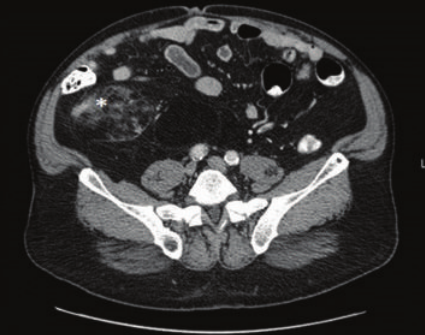
Figure 1: Right testicle doppler ultrasound, transverse superior view, showing right-sided varicocele with mild dilatation (3mm) of vessels of the pampiniform plexus. There was no corresponding dilatation of vessels of the left pampiniform plexus.